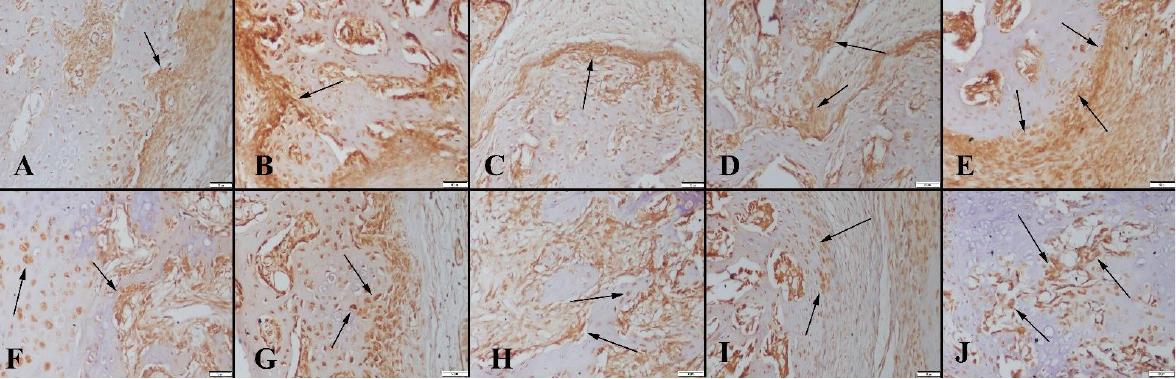
( D ) Group 3 and ( E ) Group 4, for 4-week and ( F ) Control group, ( G ) Group 1, ( H ) Group 2, ( I ) Group 3 and ( J ) Group 4, for 8-week, arrows indicate immunopositive cells, Streptavidin biotin peroxidase method, scale bars = 50 µ m.